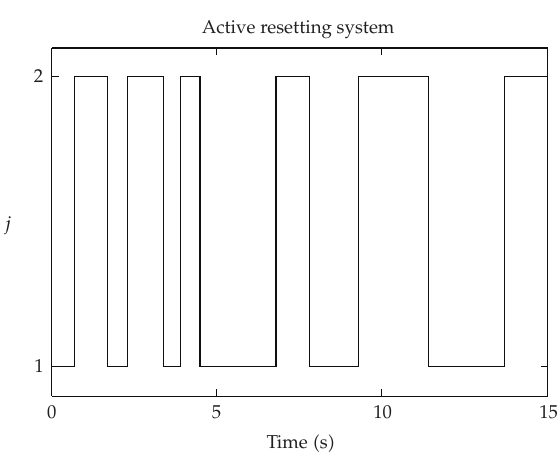
Figure 3: Sequence of switching instants between resetting